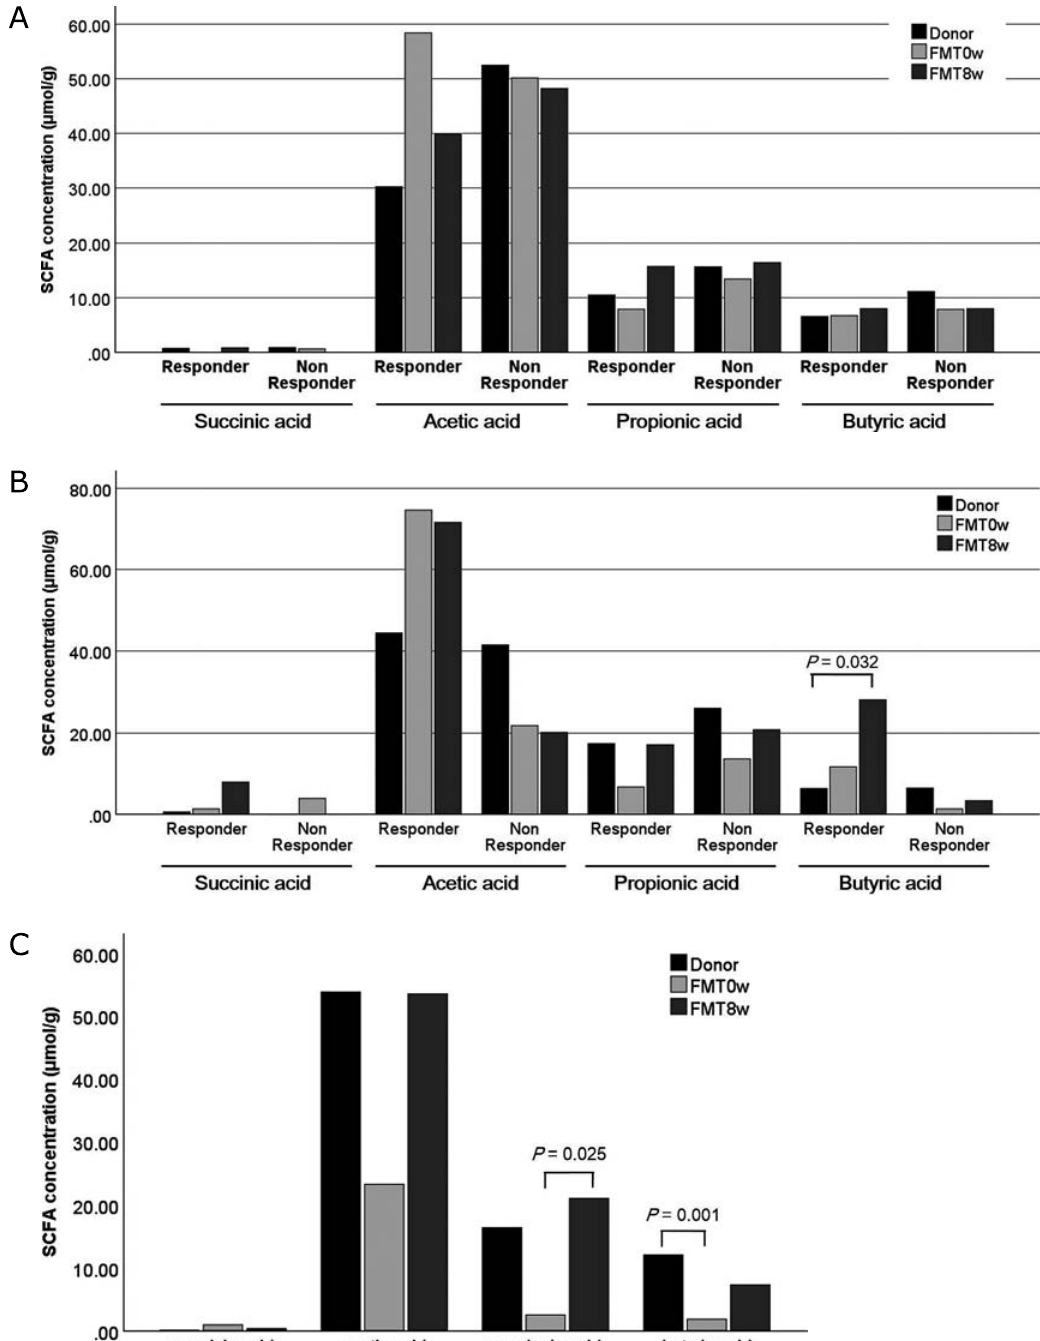
Figure 4 Fecal short-chain fatty acid concentrations. Statistical analysis was performed using the Mann–Whitney U test. A. Ulcerative